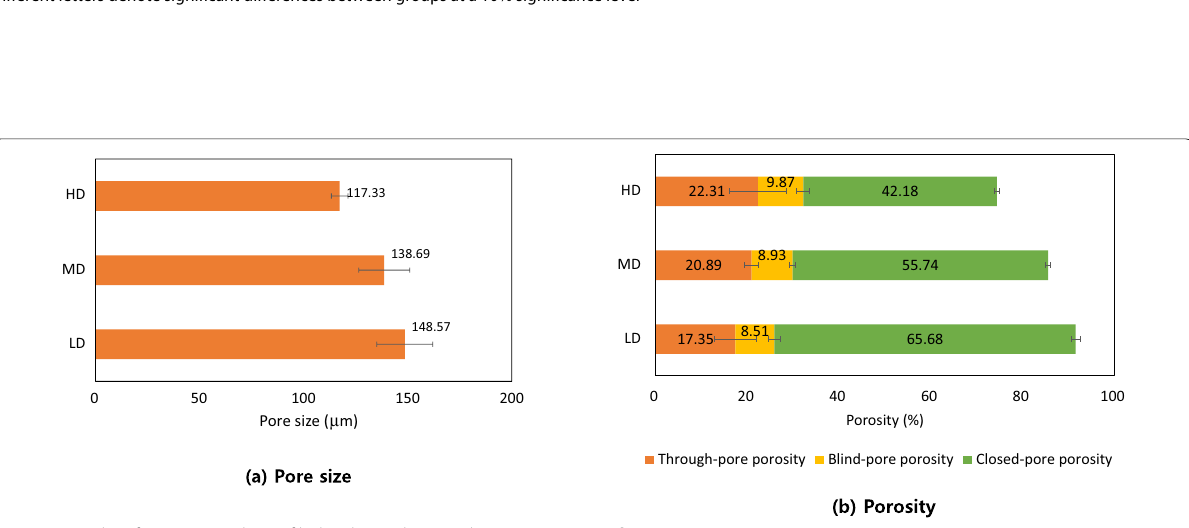
is standard deviation ± Different letters denote significant differences between groups at a 10% significance level